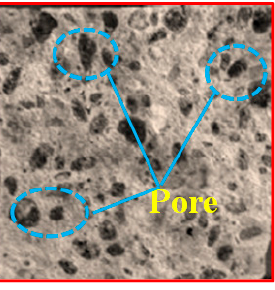
Figure 18. Cross section of thermal insulation concrete material [106].